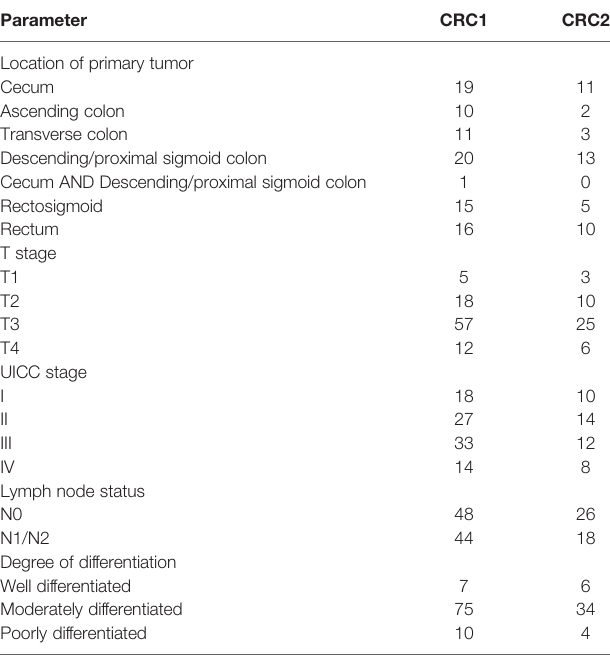
TABLE 2 | Clinical characteristics of the CRC